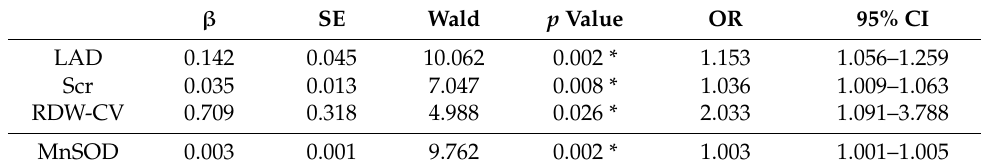
Table 3. Multivariate logistic regression analysis on predictors of paroxysmal AF.